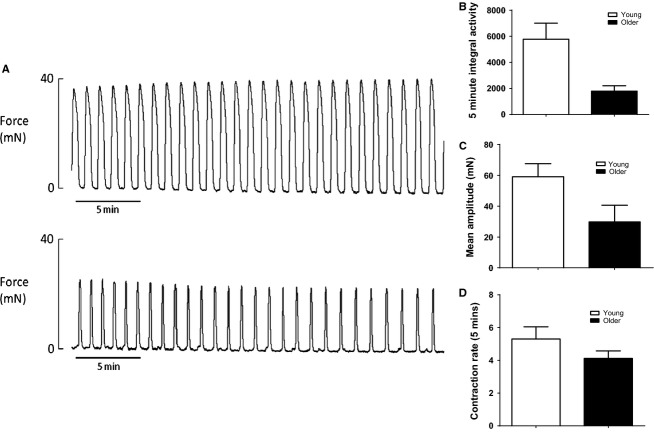
The effects of maternal age on spontaneous uterine contractions in laboring rats. (A) Represents recordings of spontaneous uterine contractile activity in a YOUNG (top trace) and OLDER (bottom trace) rat dam. B, C, and D are different measures of contractile activity in the myometrium of YOUNG (n = 4) and OLDER (n = 7) rats where (B) Represents 5 min integral activity, (C) Mean amplitude of contraction, and (D) 5 min contraction rate. Data were analyzed by one way ANOVA and significant differences between maternal age were determined at the P < 0.05 level. Statistical analysis revealed that spontaneous integral activity and contraction rate was significantly greater in myometrial strips of YOUNG compared to OLDER rats, with values of P < 0.03 and P < 0.05, respectively. Although the mean amplitude of spontaneous contractions was also higher in YOUNG animals versus their OLDER counterparts, it did not reach significance with P = 0.057.